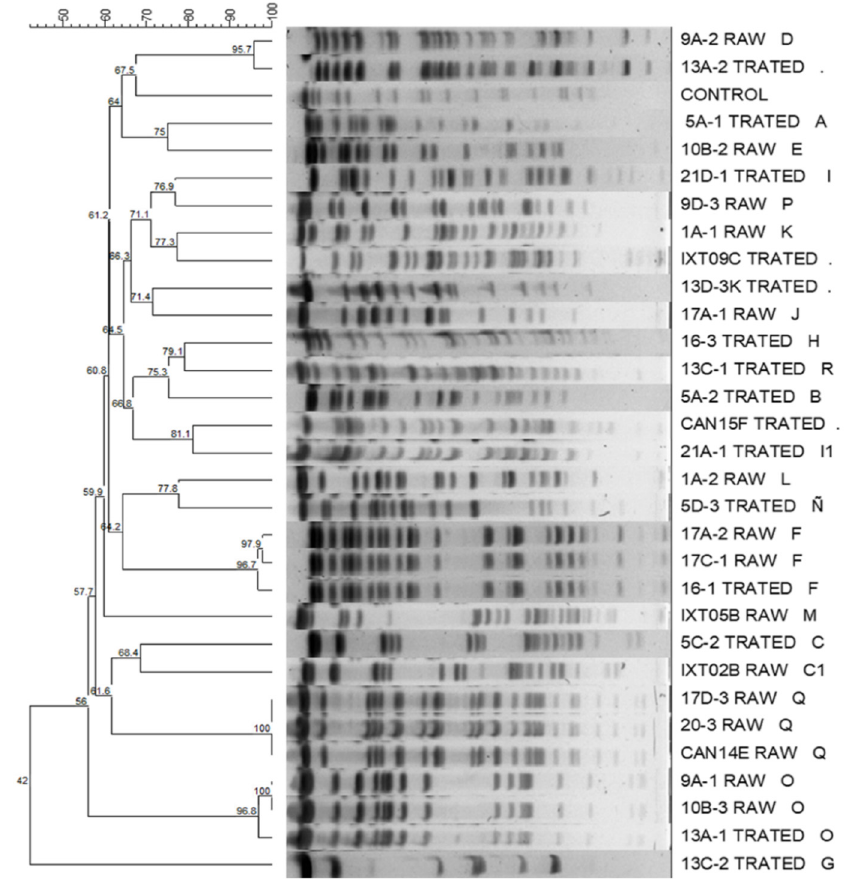
Figure 1. Dendrogram based on pulsed-field gel electrophoresis (PFGE) patterns after digestion with enzyme Xba I of Klebsiella spp. isolates isolated from hospital wastewater.